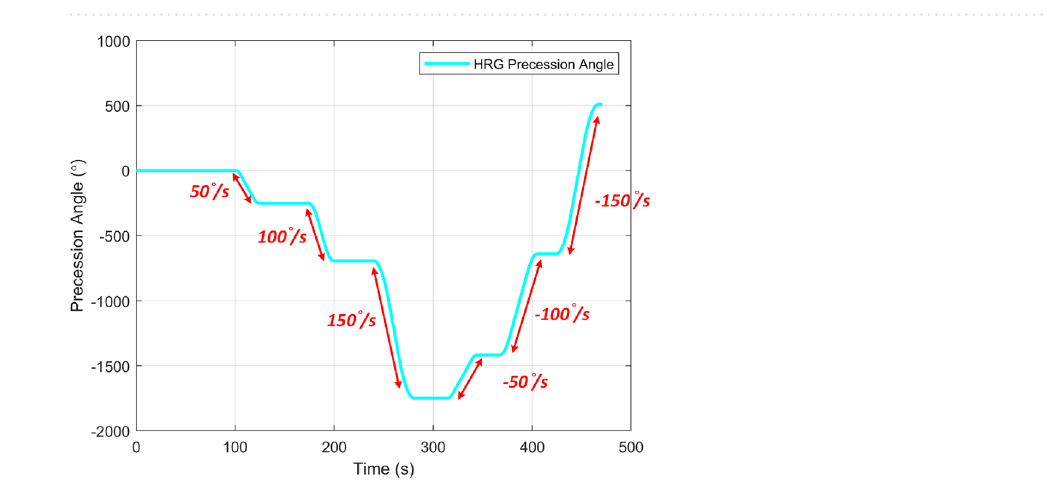
Figure 11. Dynamic range comparison of the conventional rate mode and RIG of the HRG.